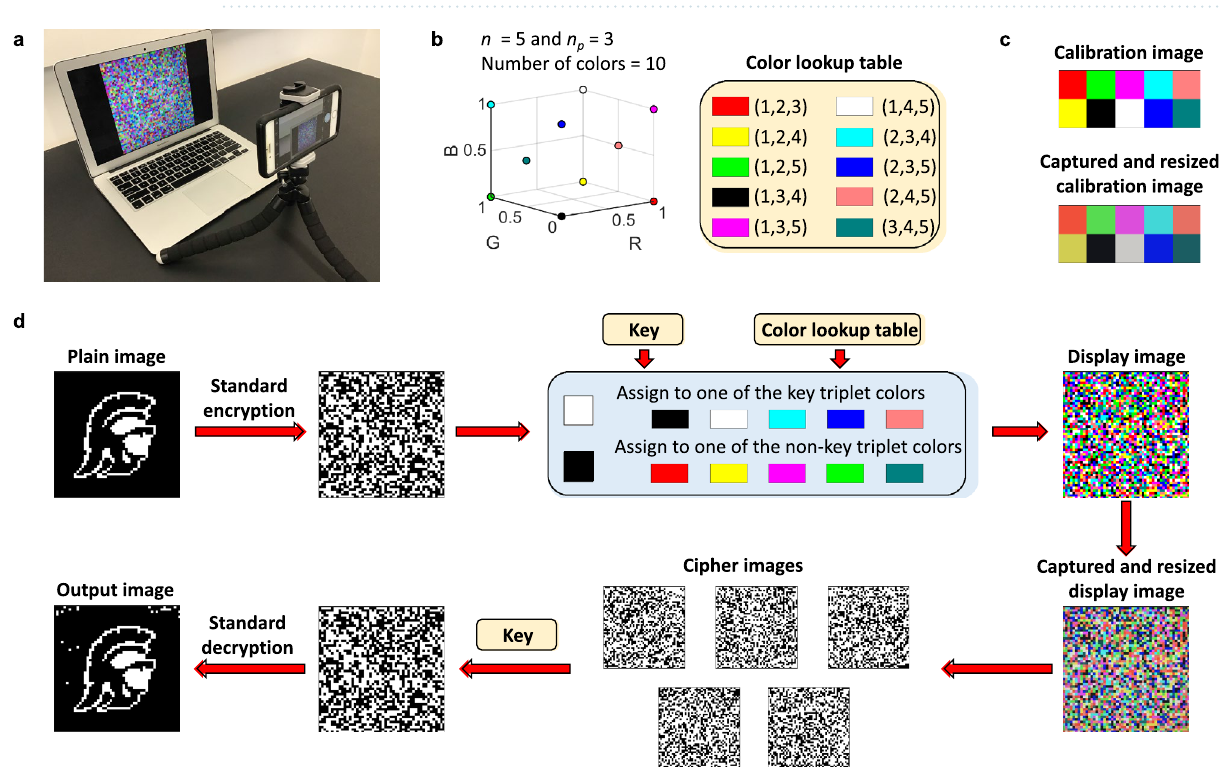
Figure 7. Table-top demonstration of our encryption scheme. (a) A computer screen displays an image which is captured by a phone camera. ( b) Triplets of channels corresponding to n = 5 and n p = 3 are mapped to 10 colors in the RGB space to generate a color lookup table. ( c) A calibration image comprising of all 10 colors displayed on the computer screen is captured and resized to the original resolution, to account for color distortion. ( d) A 50 × 50 pixel binary image of the USC Trojan logo is converted to a random display image using a key and the color lookup table. The display image is captured by a camera, resized and converted into a set of 5 cipher images using the calibrated color lookup table. A key is then used to convert the cipher images into an output